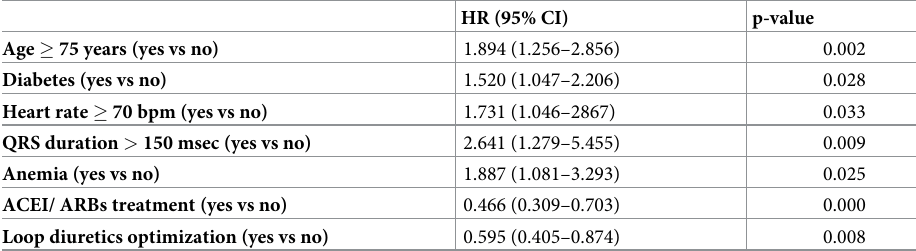
Table 3. Predictors of all-cause of 1- year mortality in CHF patients (multivariable analysis).